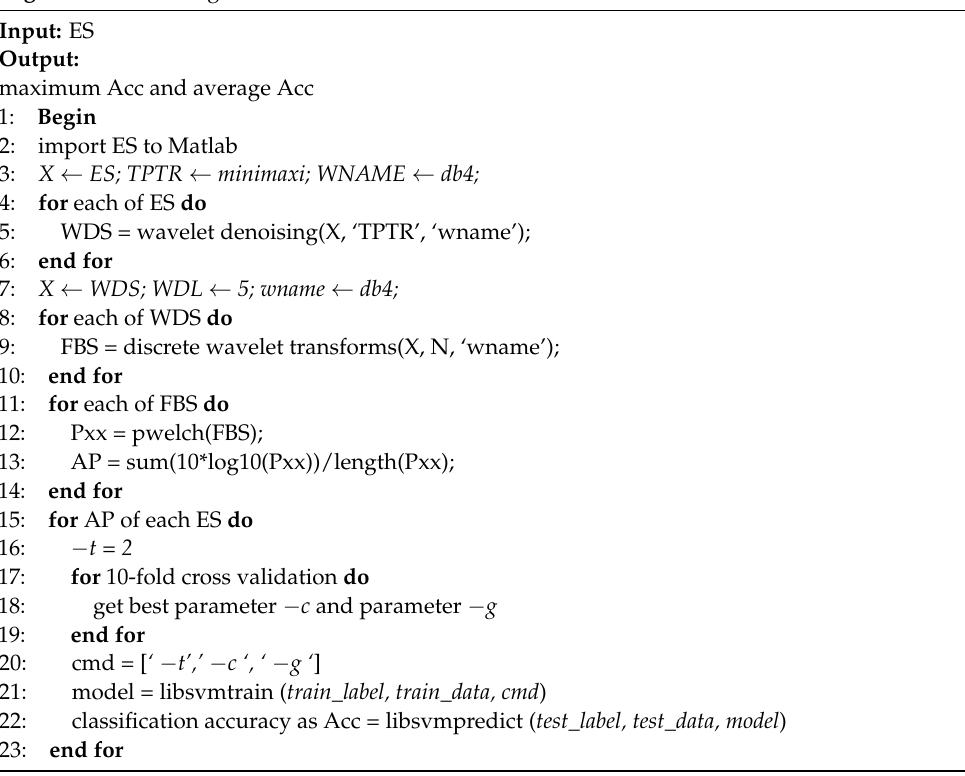
Algorithm 1: EER Algorithm